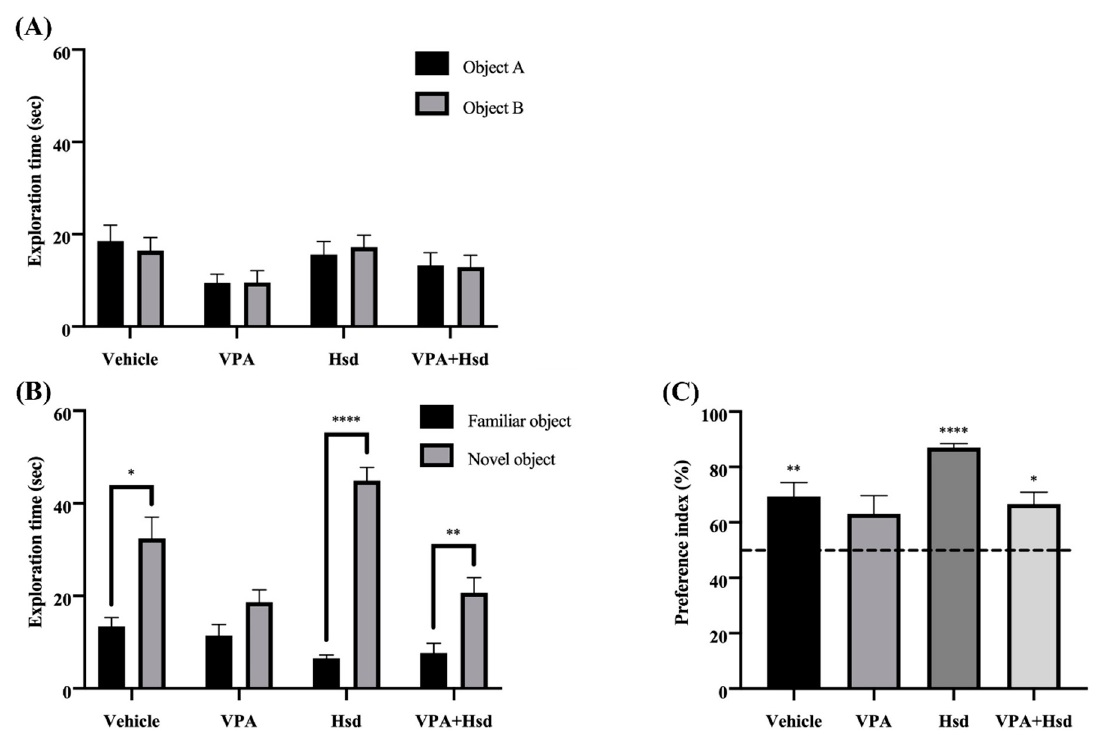
Figure 4. Improvement of VPA-induced memory impairment by Hsd co-administration in the NOR test. During the familiarization trial ( A ), there was no significant difference in the exploration times across all four groups for either object A or object B ( p > 0.05). In the choice trial ( B ), the rats in the vehicle, Hsd, and VPA+Hsd groups explored the novel object significantly more than the familiar object (* p < 0.05, **** p < 0.0001, and ** p < 0.01, respectively). In contrast, the rats in the VPA group did not explore the novel object significantly more than the familiar object ( p > 0.05). The PIs were significantly higher than 50% chance in the vehicle, Hsd, and VPA+Hsd groups (** p < 0.01, **** p < 0.0001, and * p < 0.05, respectively; ( C ) while the PI for the VPA group showed no significant difference from 50% chance ( p > 0.05).